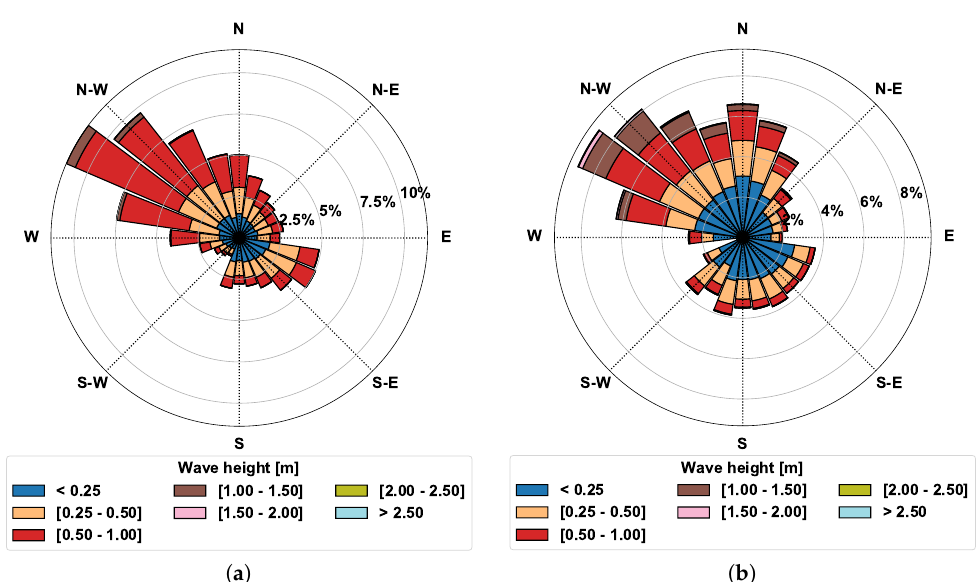
Figure 8. Wave roses from SPM ’84 ( a ) and from ADM ins ( b ).